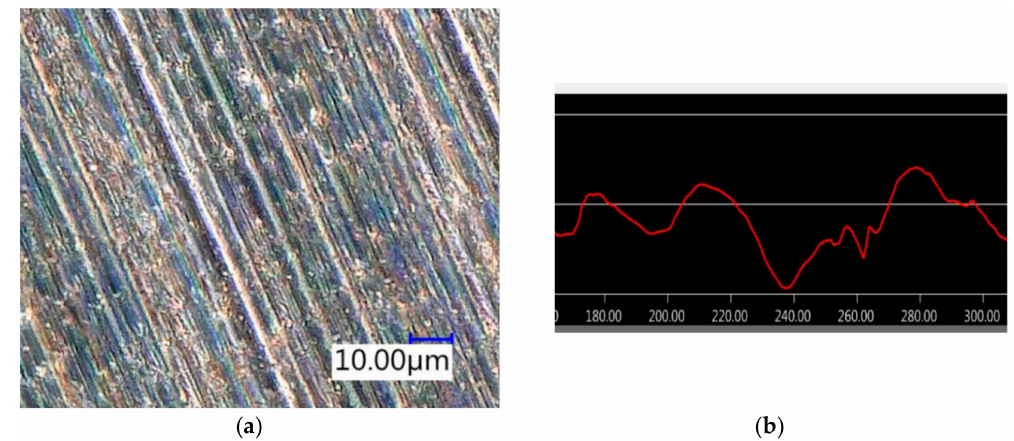
Figure 10. Microstructure ( a ) and profile ( b ) of machined surface under MQL condition.